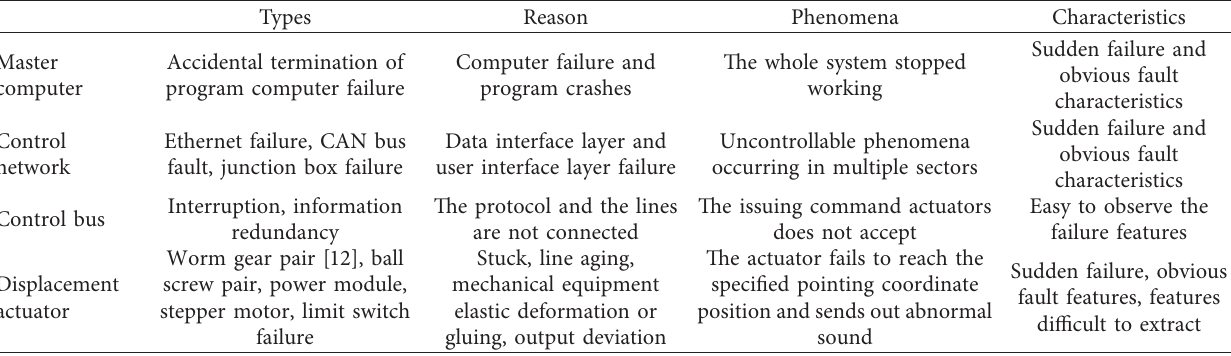
Table 1: QTT failure mechanism analysis at the ASAS [10–12].